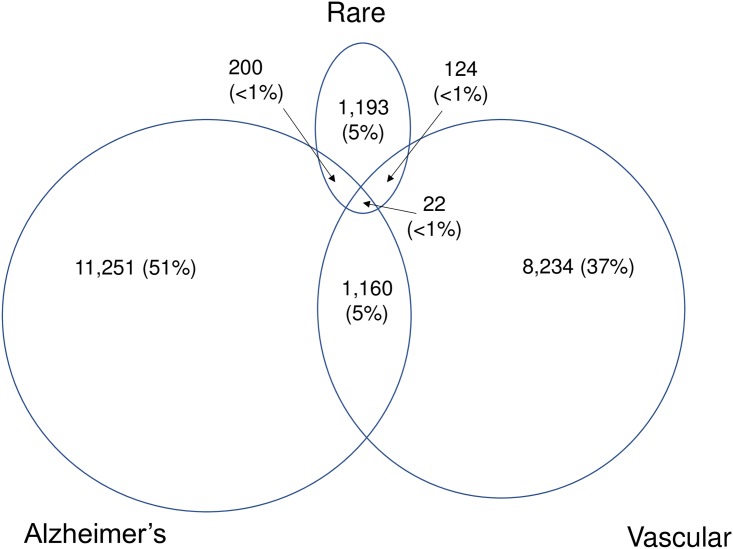
Capture of dementia in EHRs across the entire registration period in primary care, hospital episode statistics, and death records.